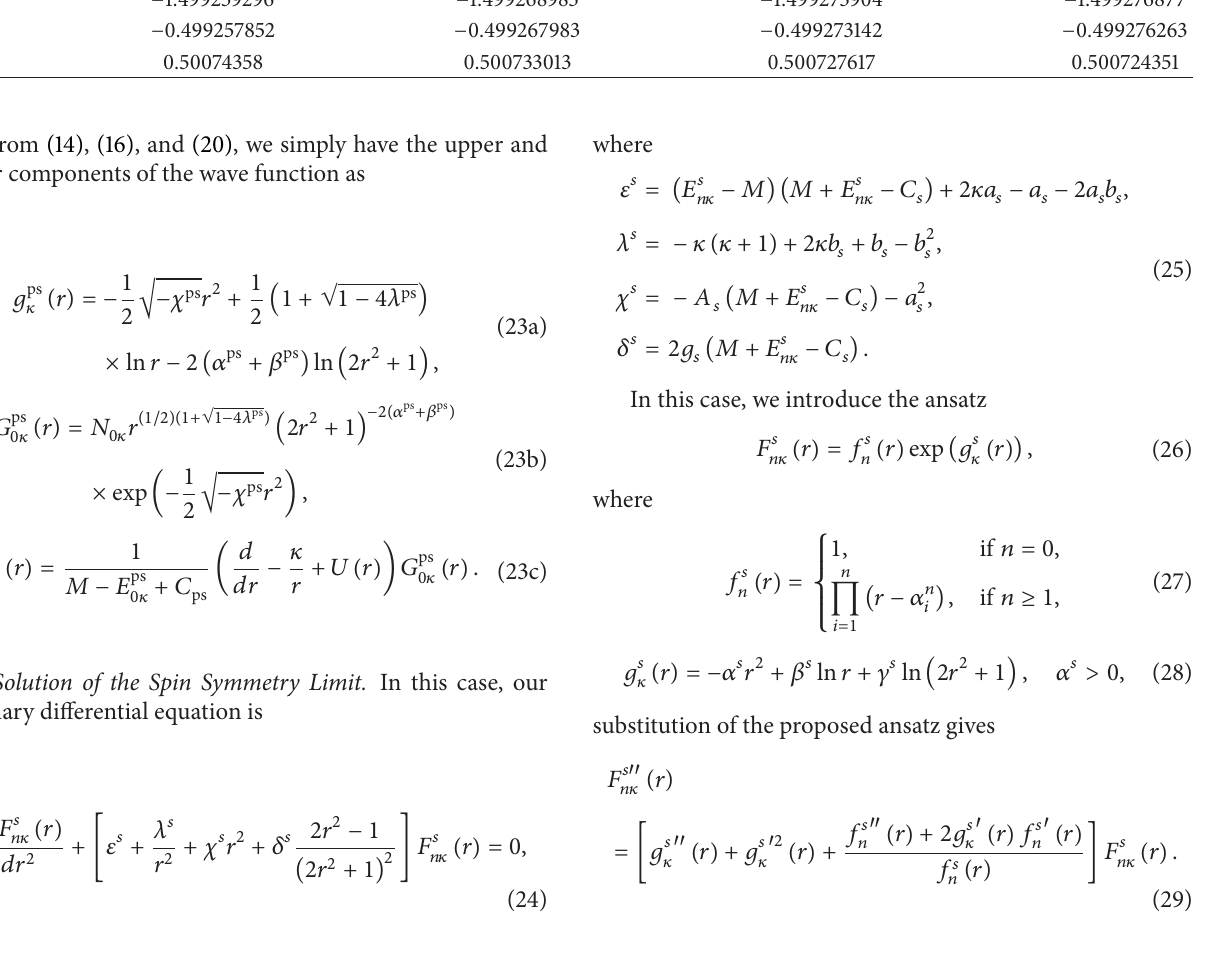
Table 3: Energies in the pseudospin symmetry limit for 𝐴